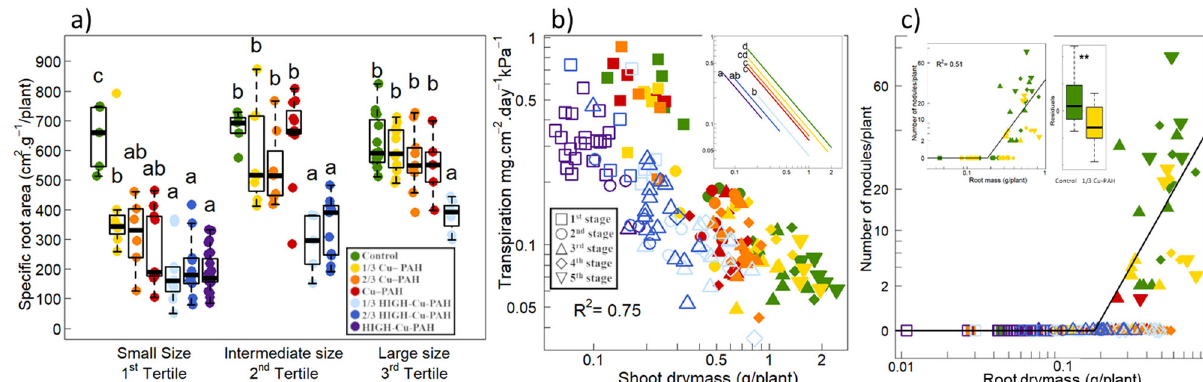
Fig. 1 Effect of soil treatments on root development and the capture of belowground resources. In all panels, soil treatments are indicated by different symbol colours. In panel b , c , development stages are indicated by different symbols (see legend in panel b ). a Impact on Speci fi c Root Area (SRA). Because the response was in fl uenced by plant size, all plants were split into three groups according to root biomasses tertiles. Because of the toxic effect on plant growth (Table 1), plants from the highest phytotoxic soils (2/3 HIGH-Cu-PAH and HIGH-Cu-PAH) are not represented in the highest size class (third tertile), and plants from the HIGH-Cu-PAH soil are not represented in the intermediate size class (second tertile). For each size group, ANOVA were performed to detect differences of SRA with soil treatments. Different letters indicate signi fi cant difference between soil treatments (post-hoc Tukey pairwise comparisons). b Size-dependent transpiration in fl uenced by soil treatment. Results of the ANCOVA show a strong in fl uence of soil treatments on the intercept of the relationship between shoot biomass and transpiration ( P < 0.001). Modelled relationships are shown in the top right inset where different letters indicate signi fi cant differences of intercept (post-hoc Tukey pairwise comparisons). c Size-dependent relationship between root biomass and the total number of nodules. The segmented regression shown is highly signi fi cant ( P < 0.001 for the existence of a breakpoint, Davies test) indicating an absence of nodulation when root mass is inferior to 0.19 g, then a positive relationship with an increasing number of nodules with root mass. Note that nodule number was square root-transformed. In the top left inset, the same segmented relationship is shown for plants growing in the control and the 1/3 Cu-PAH soils. Residuals of the increasing relationship (on the right of the breakpoint) are shown (boxplot in the top left inset), with higher residuals for the control soil ( P < 0.01, two sample t -test). See Supplementary Table 3 for corresponding degrees of freedom and associated p -values.